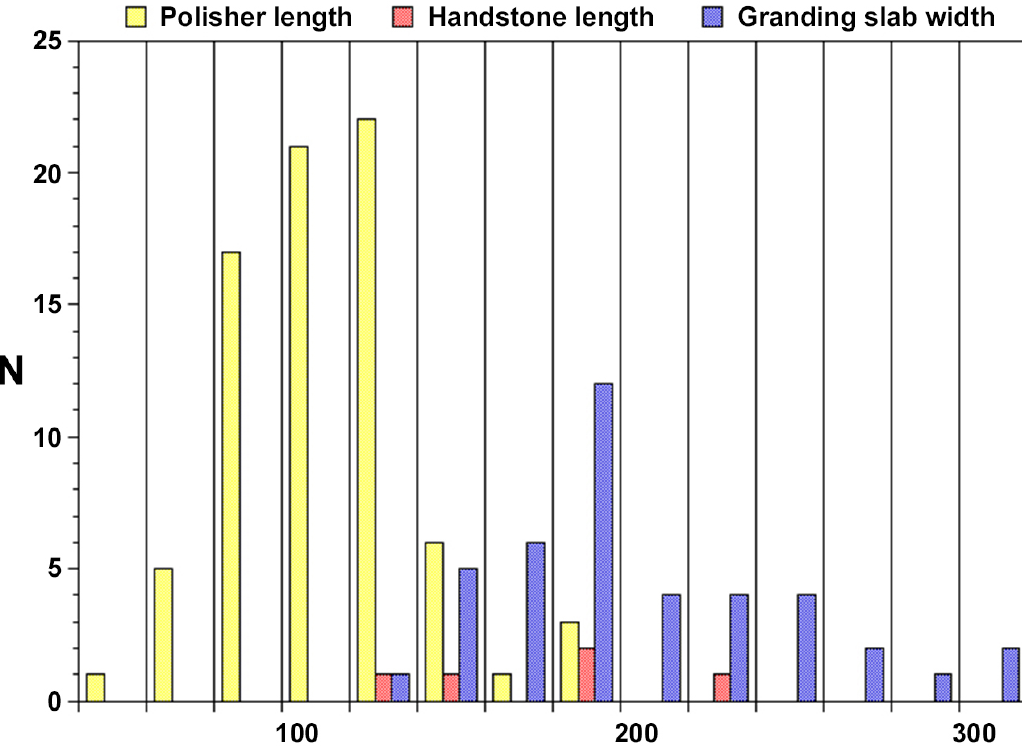
Figure 2. Comparison between the length of small abrasive tools and the width of the grinding slabs from the Bronze Age settlement of Gatas (Almería) (based on Castro et al. 1999: